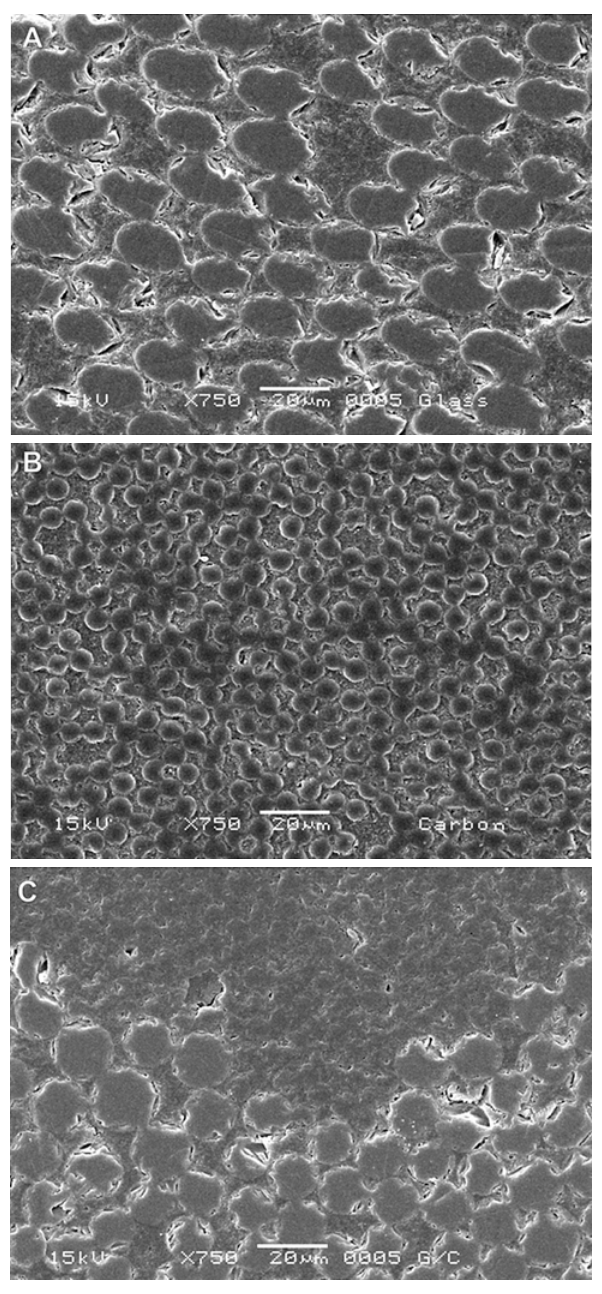
FIGURE 2- SEM micrographs of the morphological appearance of each post type. The glass fiber post (A) presented wider fibers and higher amount of organic matrix involving the fibers compared with the carbon fiber post (B). The glass/carbon fiber post (C) presented carbon fibers in the center, surrounded by glass fibers, and both fibers were involved by organic